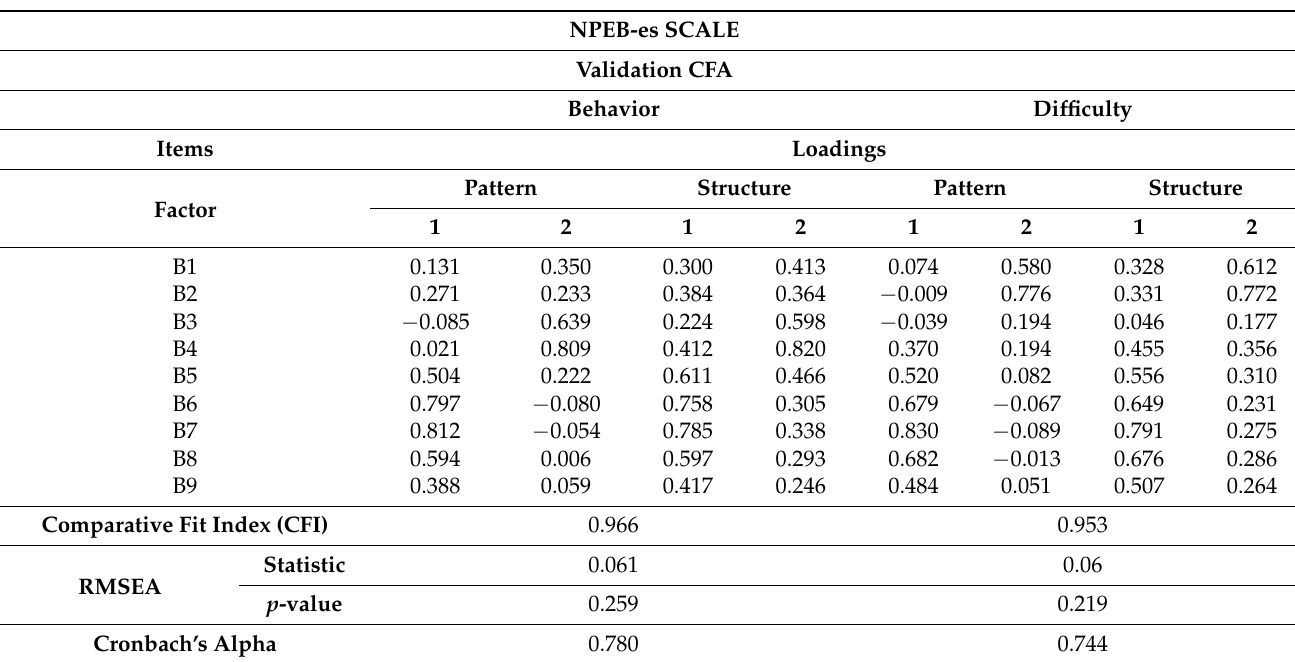
Table 5. Factor loadings and Cronbach’s alphas for the Nurse Professional Ecological